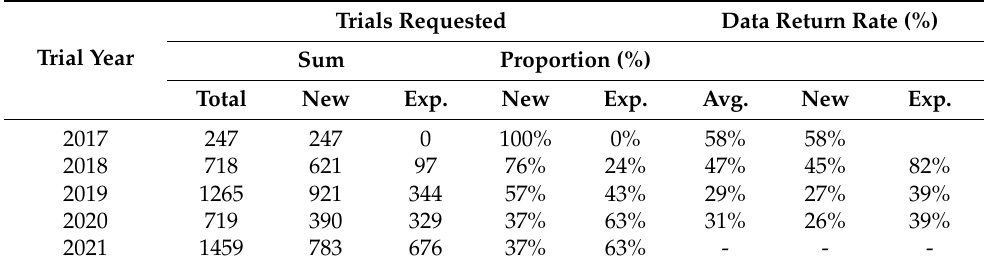
Table 3. Trials requested and data return rate by previous trial experience of participant (new vs.